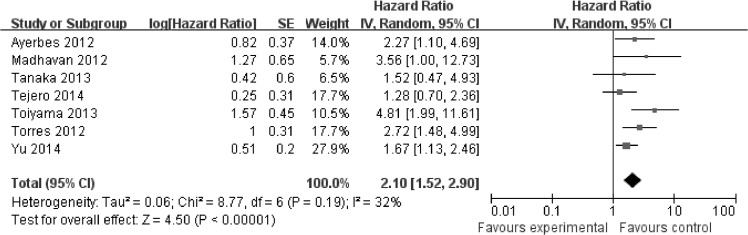
Meta-analysis evaluating miR-200c expression and overall survival (OS) for blood samples.